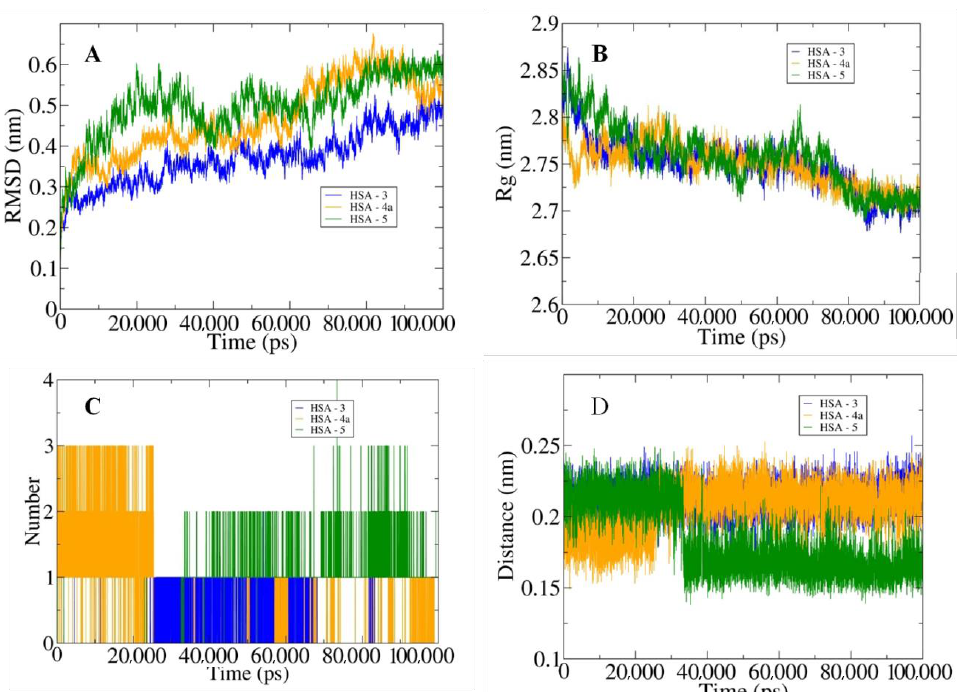
Figure 9. The outputs generated from 100 ns MD simulations with ( A ) illustration of the changes in the RMSD values for the three studied systems, and ( B ) changes in the Rg values. ( C ) Graph depicting the variation in the number of hydrogen bonds between HSA and docked inhibitors. ( D ) Curves showing the fluctuations in the calculated distances. Table 13. List of MM-PBSA-based generated energy parameters for the studied anticancer inhibitors complexed HSA.